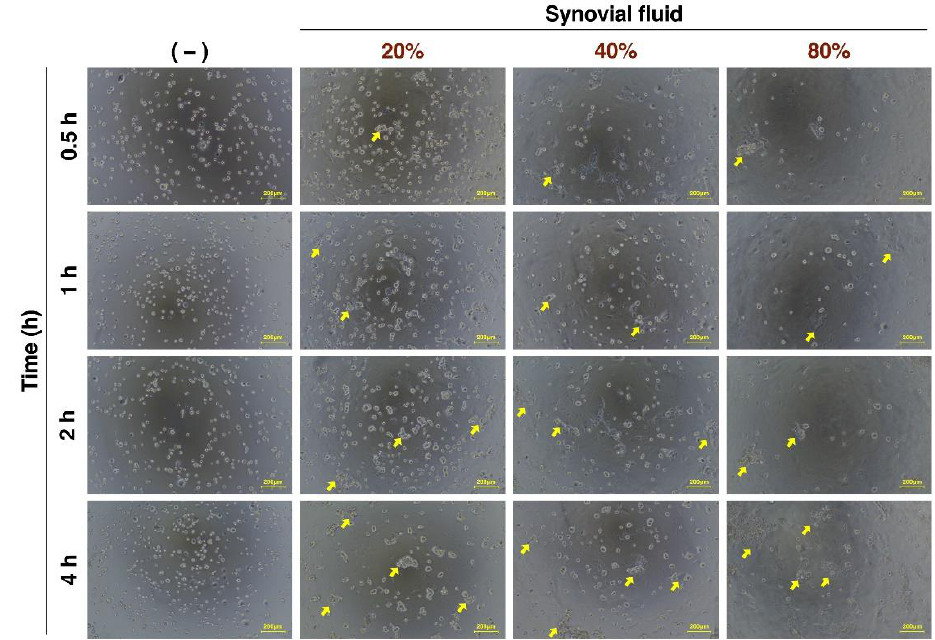
Figure 1. Microscopic images of SF-treated ADSCs over time. Images of cells observed using phase contrast microscopy. Yellow arrow represents aggregated cells. Yellow bars represent 200 μm.